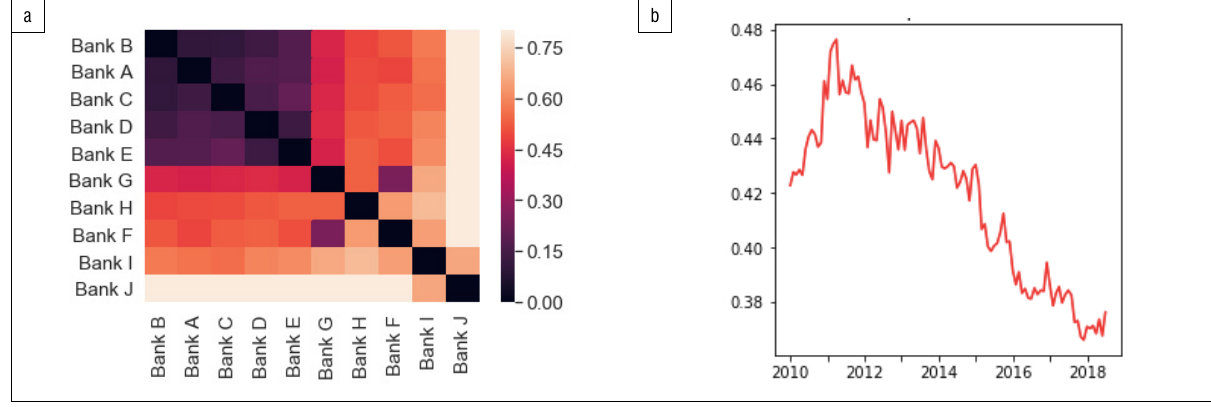
Figure 1: (a) Pair-wise Euclidean distance between top 10 banks as of February 2020. The closer (darker) the value to 0, the more similar the portfolios. (b) Average Euclidean distance from 2010 to 2020 for the largest 10 banks. The smaller the value, the more similar the largest banks in terms of asset